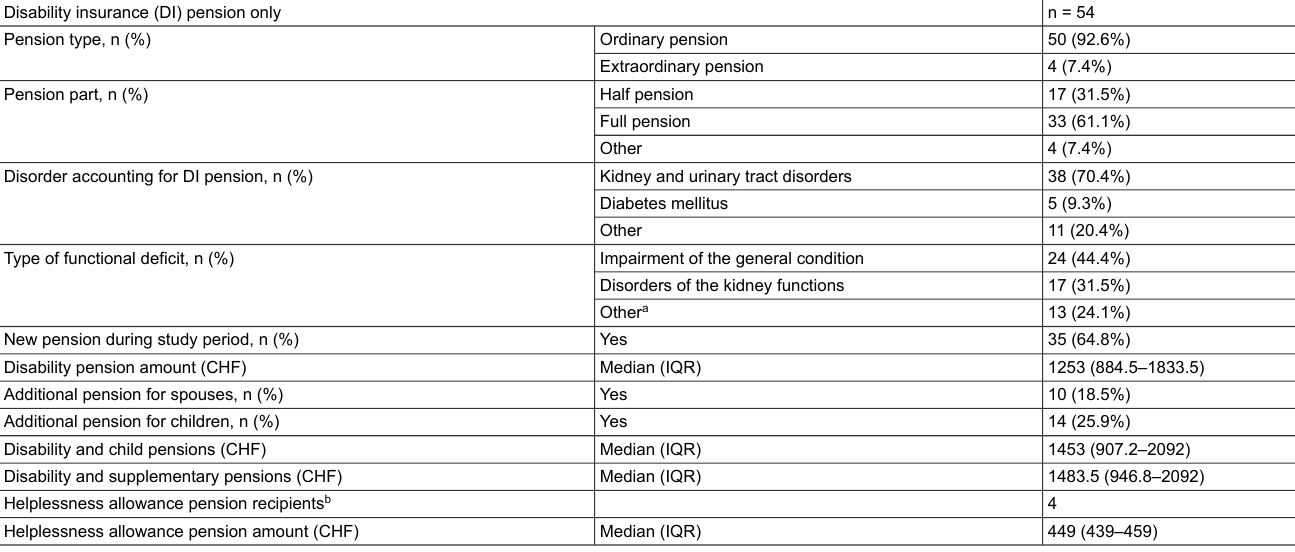
Table 3: Summary of data from the Federal Social Insurance Office for the study period of 2005 to 2015. Disability insurance (DI) pension only n =